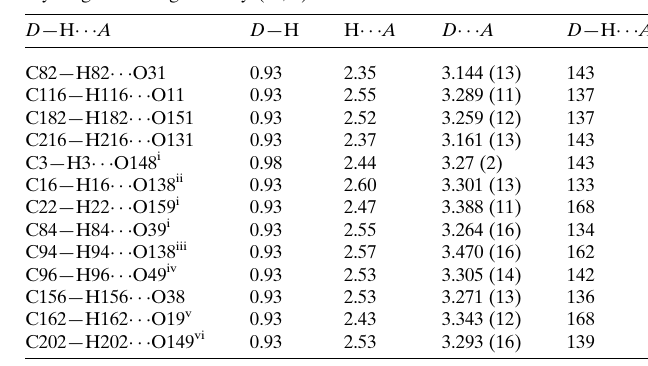
Table 1 Hydrogen-bond geometry (A˚ , (cid:4) ).